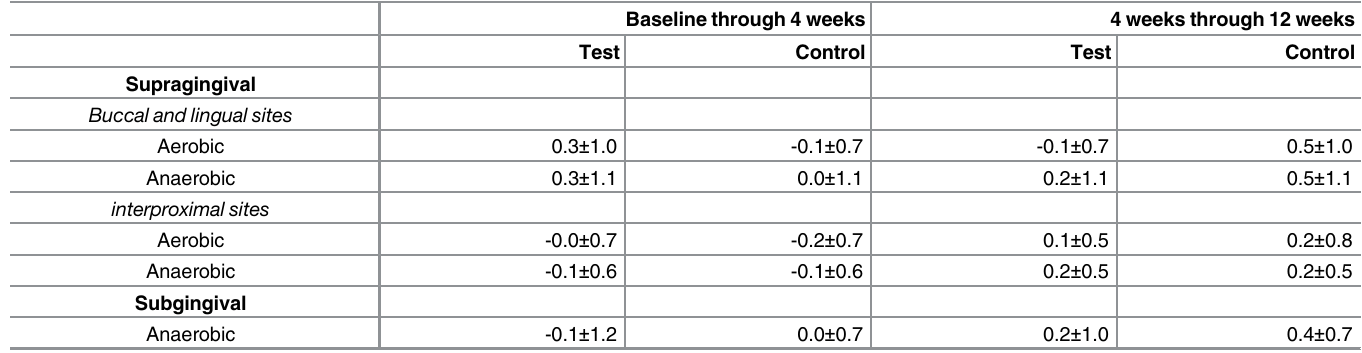
Table 4. Microbiological results from baseline through follow ups (means ± SD). Log-transformed reduction